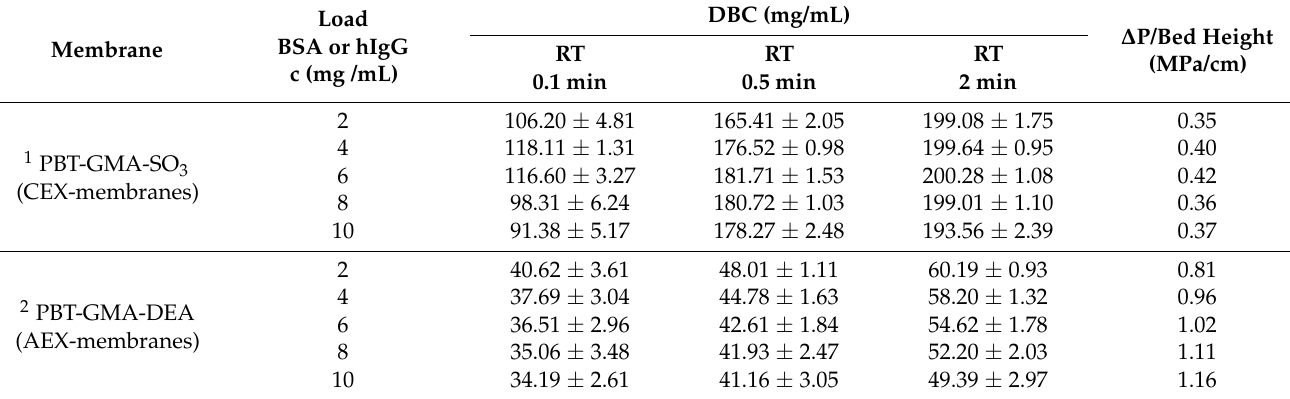
Table 3. Comparison of the DBC of BSA (for AEX) or hIgG (for CEX) at different feed concentrations and RTs.